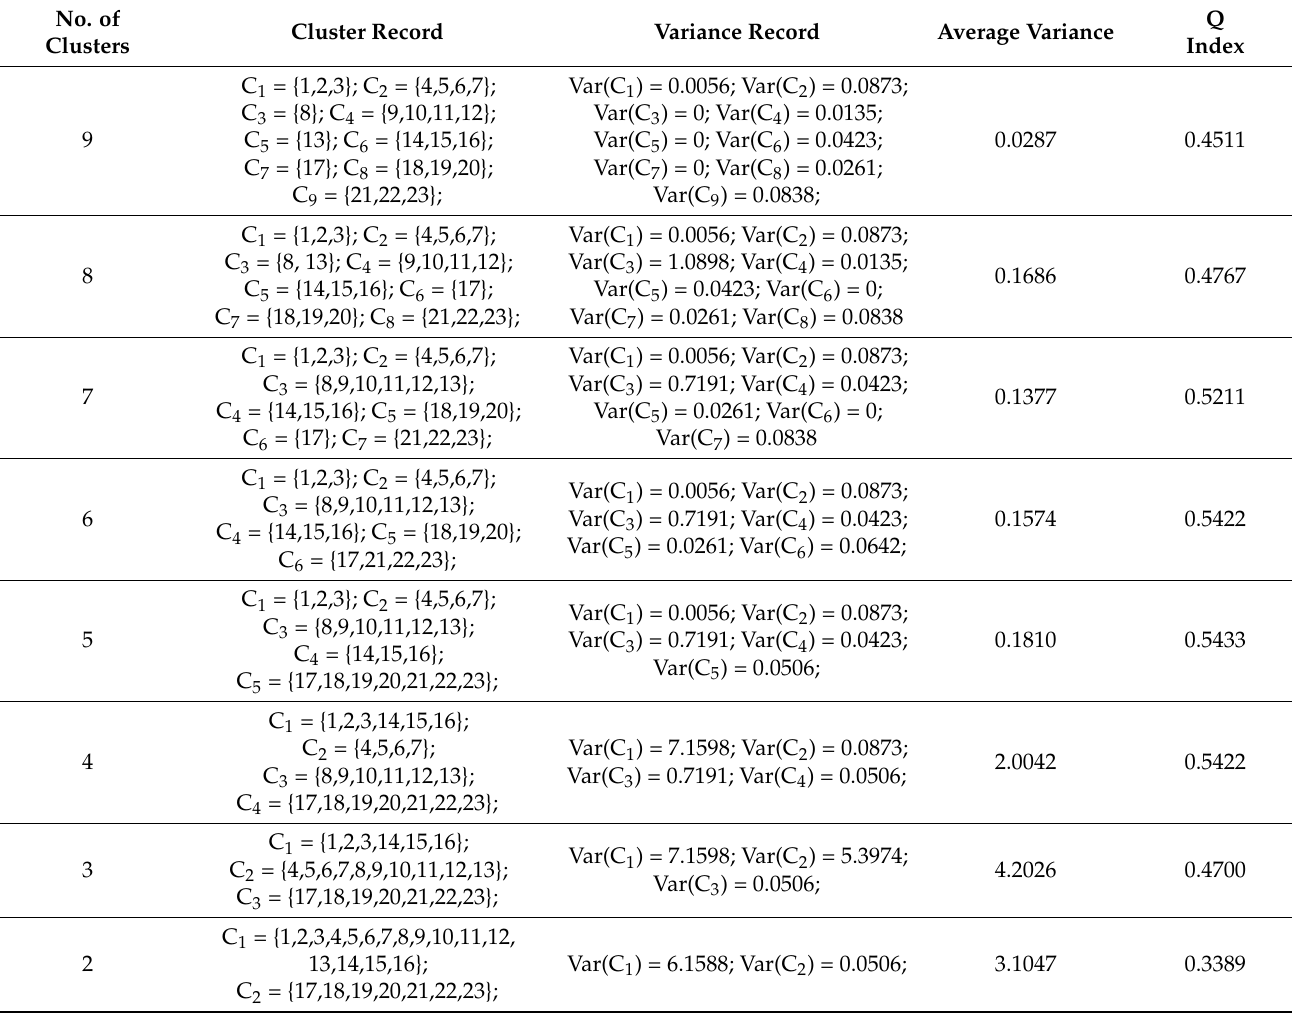
Table 1. Results for sample network clustering and comparison of